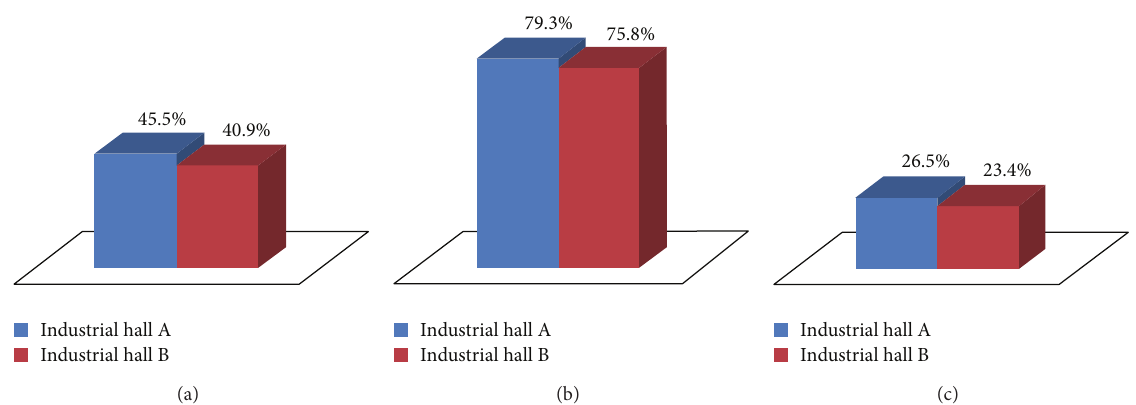
Figure 12: (a) Overall obstacle detection rate; (b) machine tool detection rate; (c) small obstacle detection rate.